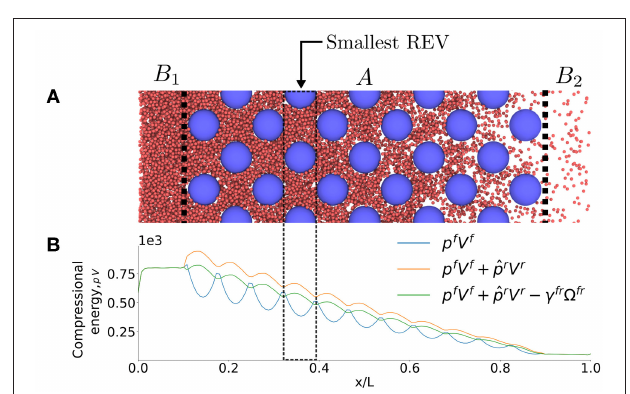
p r and surface tension γ fr as a function of pressure p for the sphere (characteristic length d ˆ 11.21 σ 0 =